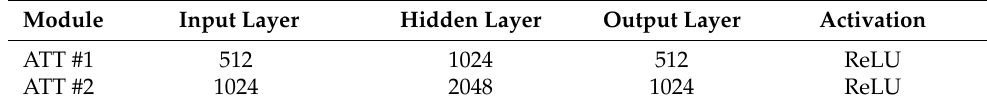
Table 2. Details on the amount of neurons for the MLPs in the two-attention module.